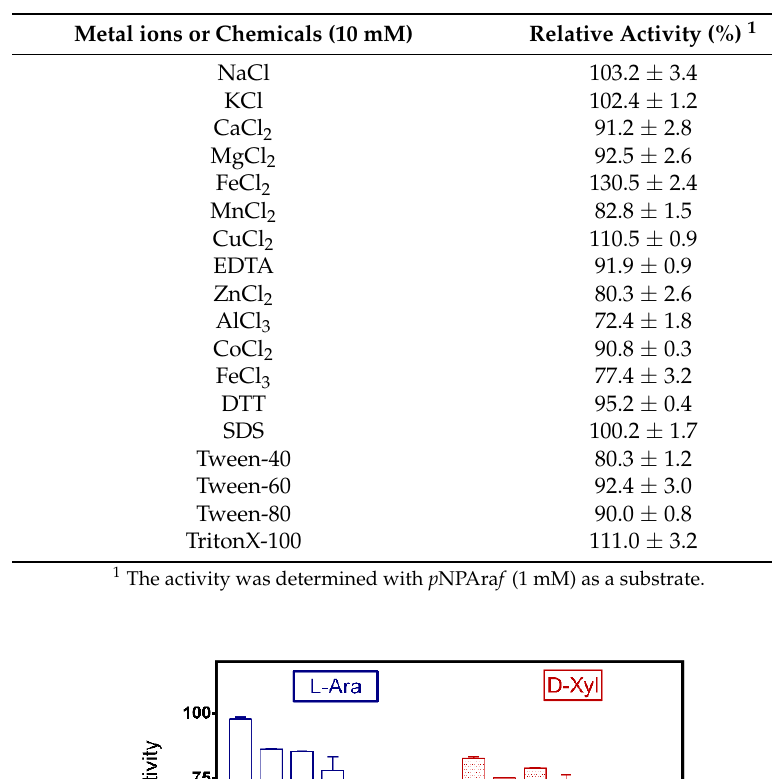
Table 4. Hydrolytic activity of Pp Abf51b on different p-nitrophenyl linked glycosides.